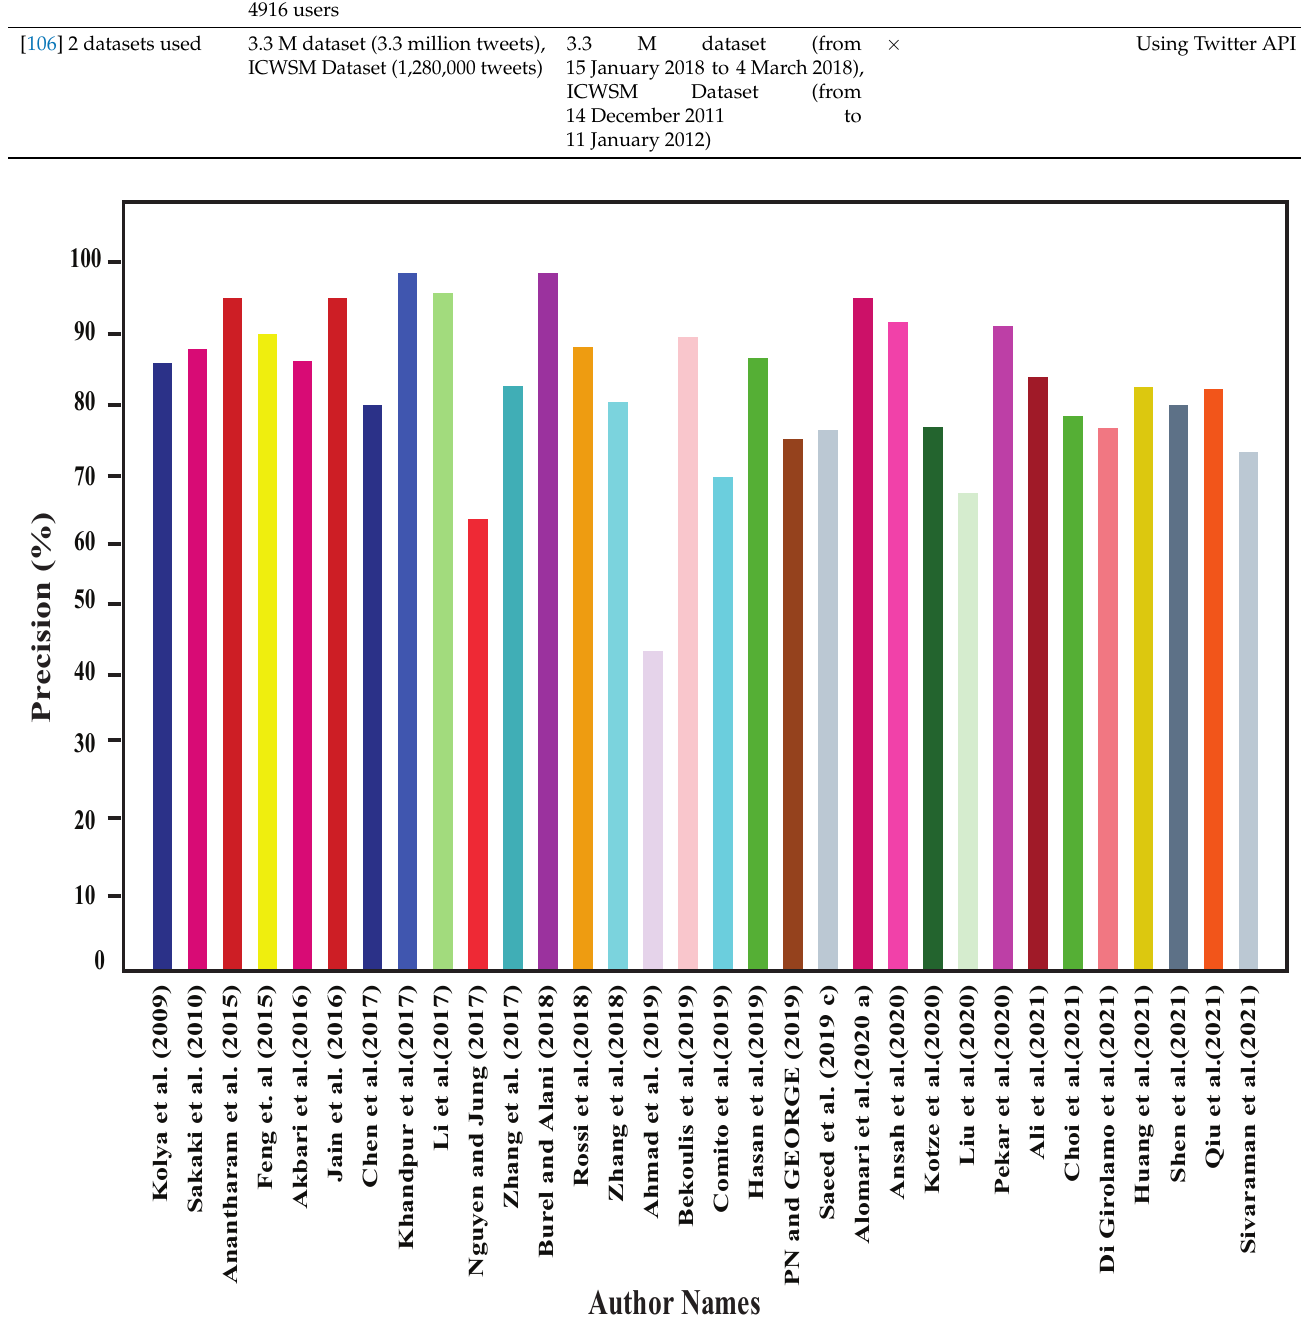
Figure 4. Precision-based performance comparisons of the articles. The height of each bar presents an article’s precision, which is given in the Y-axis, and the X-axis shows the author’s name. Refs. [8,20,32,33,36,45,47–49,53,55,59,62–67,69,70,73,75,77–79,83,90,94,97,103,106,107] have used pre- cision for their performance analysis, and their values are presented using the bars in this